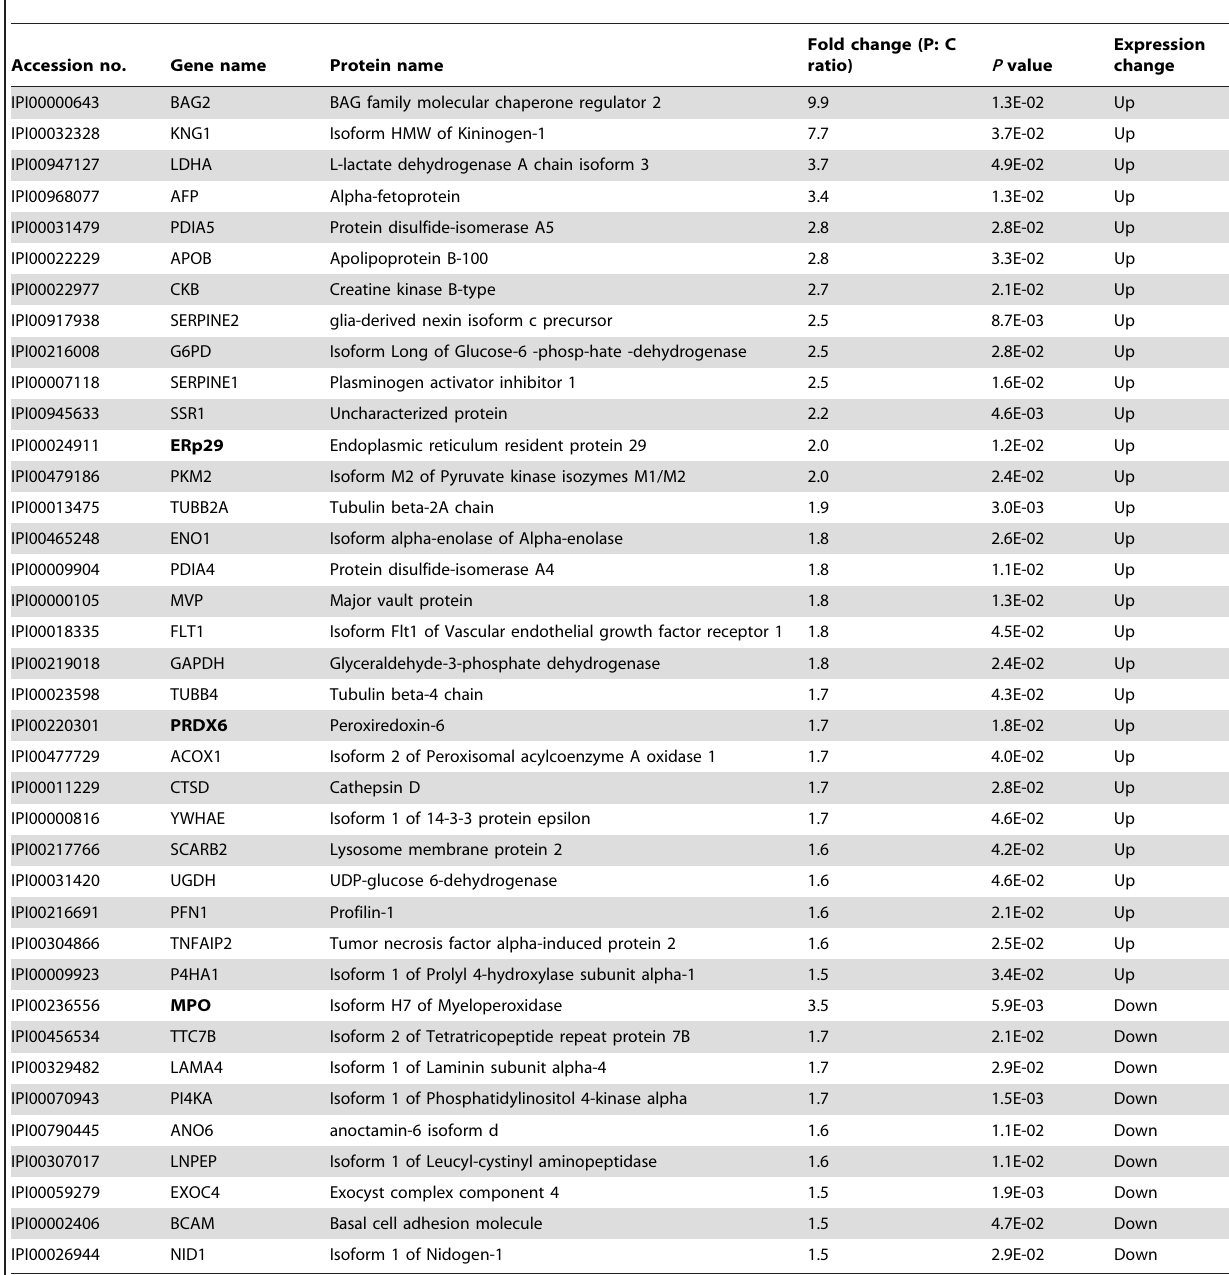
Table 2. Differentially expressed proteins in the placenta tissue from pregnant women with ICP and healthy pregnant women identified by iTRAQ labeling-based